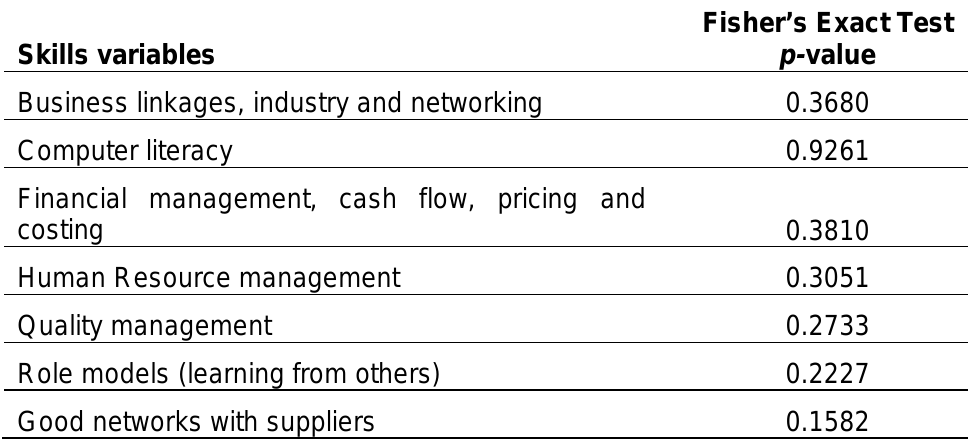
Table 2: Significant Differences Relating to Business